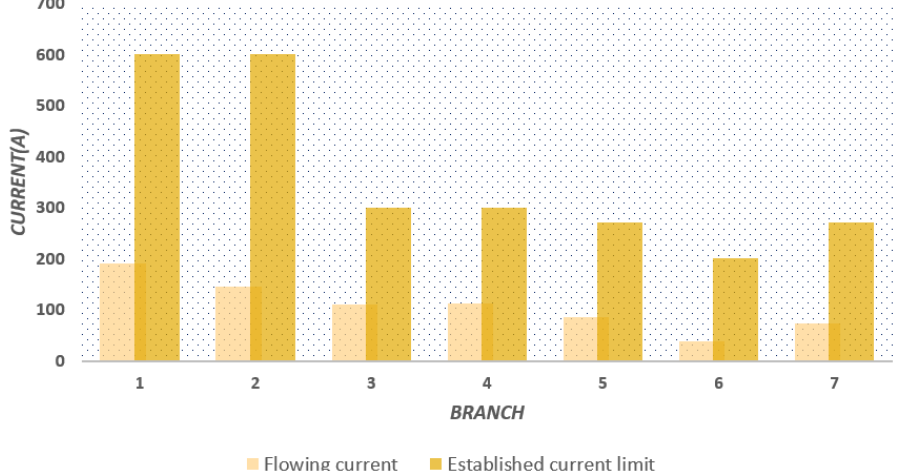
Figure 8. Loadability levels present in the branches of the three-phase 8-bus distribution system under a balanced load scenario.